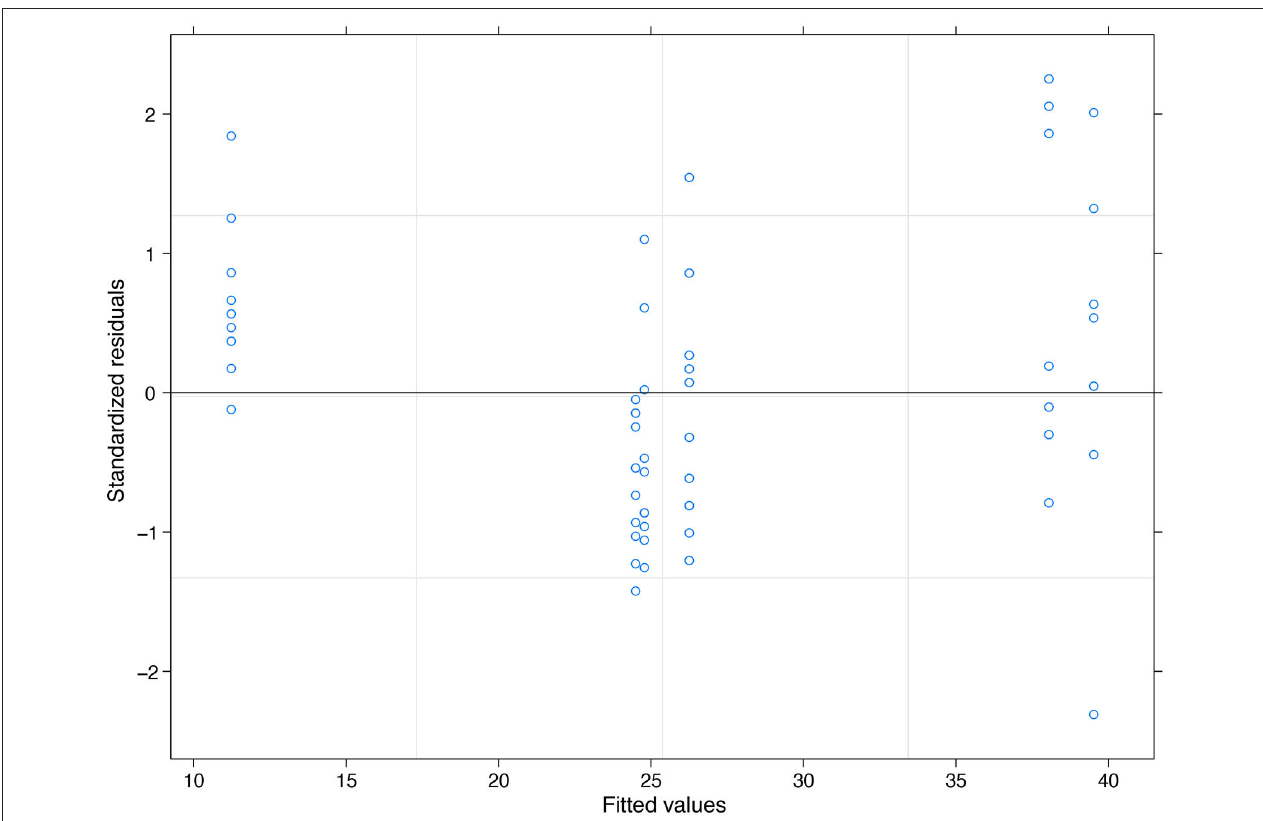
FIGURE 4 | Standardized residuals and fitted values of measured data (see Table 1 ). Since the residuals do not exhibit any systematic structure we argue that the model fits the data well. Plot with Standardized residuals (ranging from -2 to 3) on the y-axis and Fitted values on the X-axis (ranging from 0 to 15). Each residual is represented by a dot. These dots appear to be scattered randomly within the